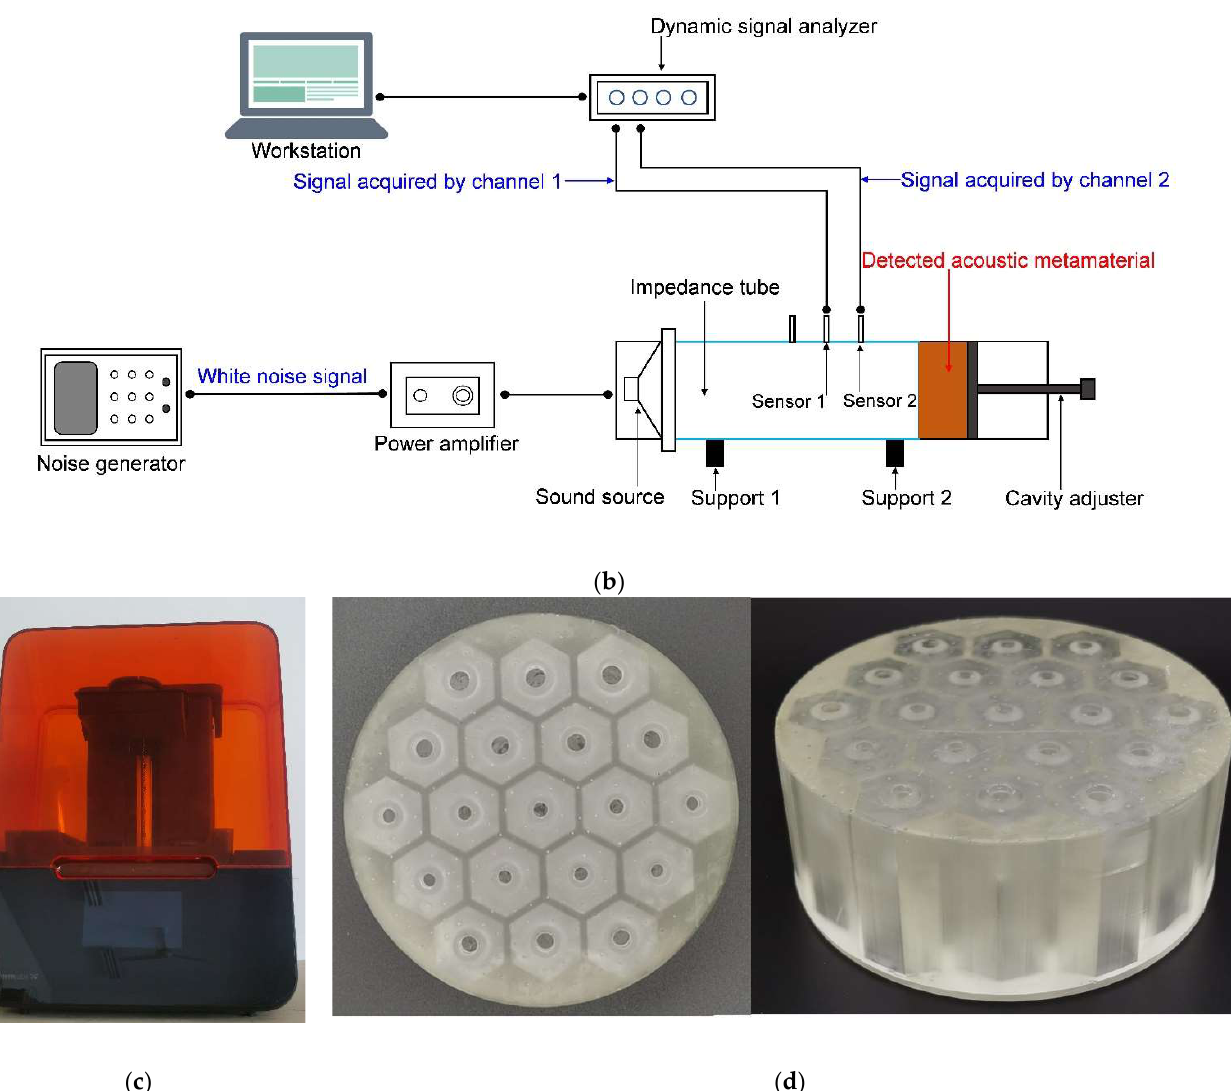
Figure 8. Fabrication and detection of the acoustic metamaterial. ( a ) The AWA6290T transfer function sound absorption coefficient measurement system; ( b ) Schematic diagram of the transfer function tube measurement; ( c ) The low force stereolithography (LFS) 3D printer of Form3; ( d ) The 3D printed sample of acoustic metamaterial with the diameter of 100 mm and the thickness of 40 mm.